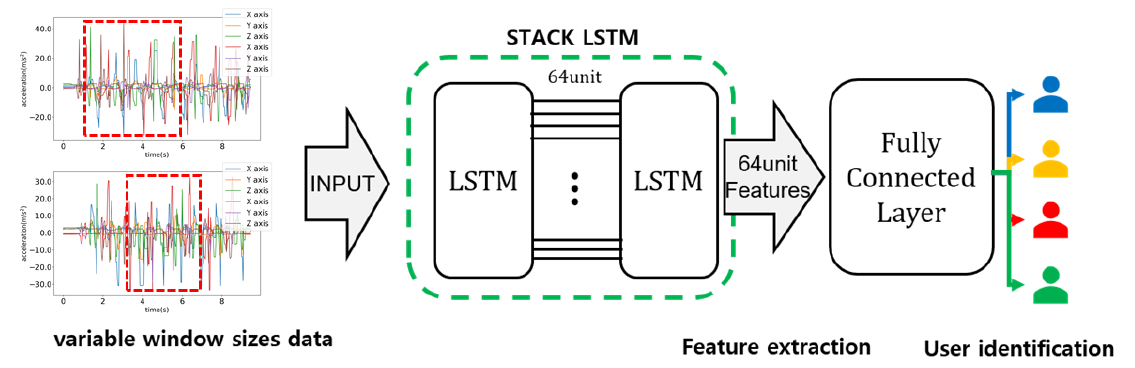
Figure 6. Stack LSTM network with an input of a random size and random location for the user